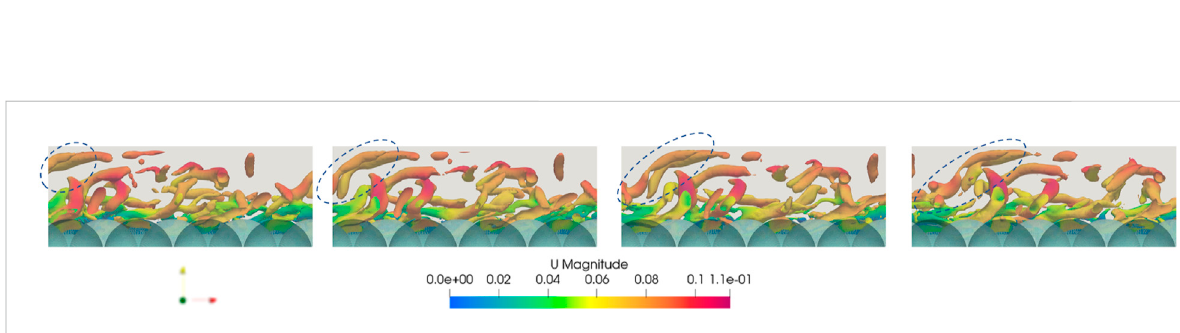
FIGURE 12 Consecutiveframesfrom36.1to36.4 at0.1 sintervalsusingQ-criteronwiththreshold=20.Onlystructuresina0.02 mslicesectionareshown (taken from − 0.01 m to 0.01 m in the spanwise direction).